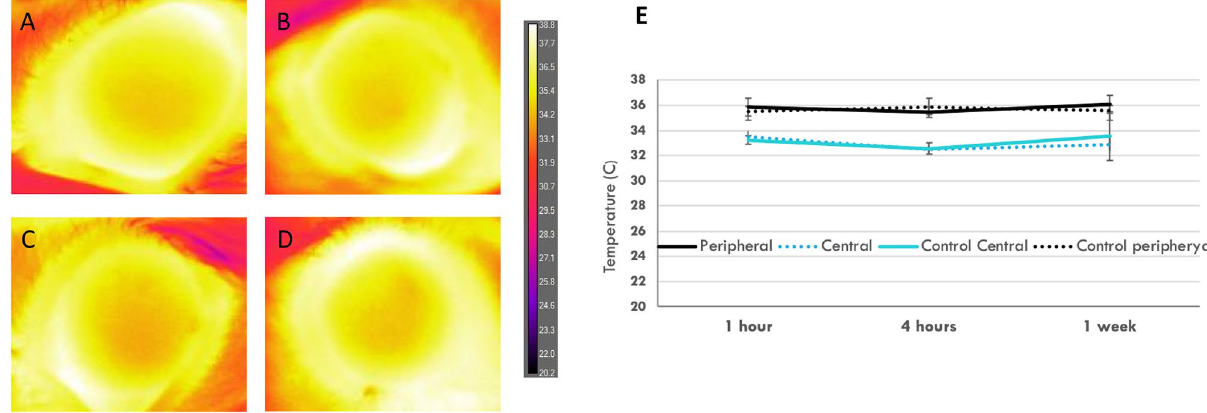
Figure 4. Representative thermographic maps showing the ocular surface temperature for the control ( A ), 1 h ( B ), 4 h ( C ) and 1 week after 4 h-exposure groups ( D ). The temperature was lower in the central area than that in the peripheral cornea, but no significant change was observed after different periods of exposure ( E ).